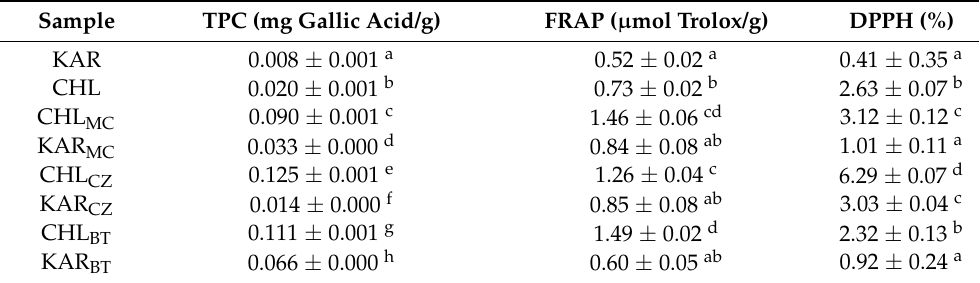
Table 2. Total polyphenol content and antioxidant properties (Ferric Reducing Antioxidant Power (FRAP) and DPPH) of edible films.